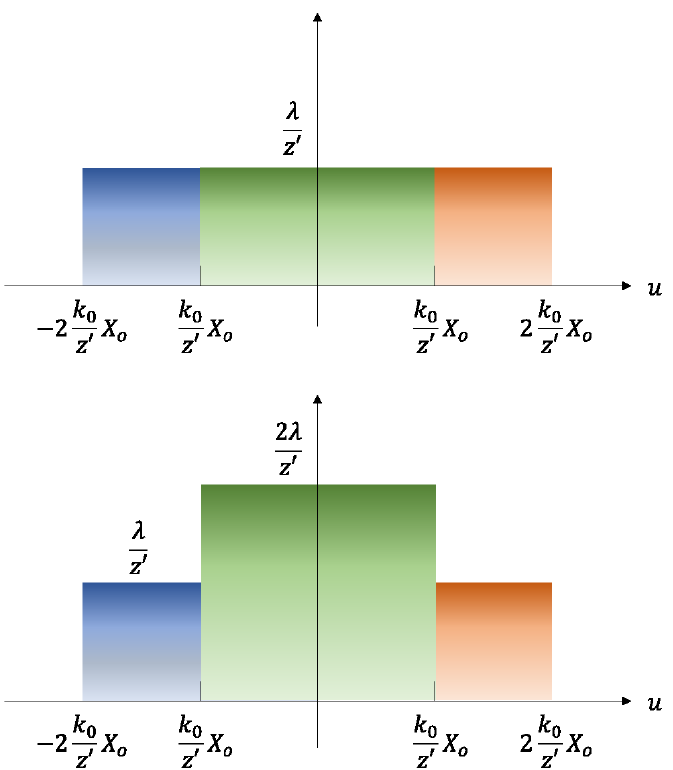
Figure 3. Case of three views S i = {− X o ,0, X o } . The top panel gives a qualitative view of the frequency bands that now overlap. The bottom panel shows the spectrum of the kernel in terms of disjoint bands.